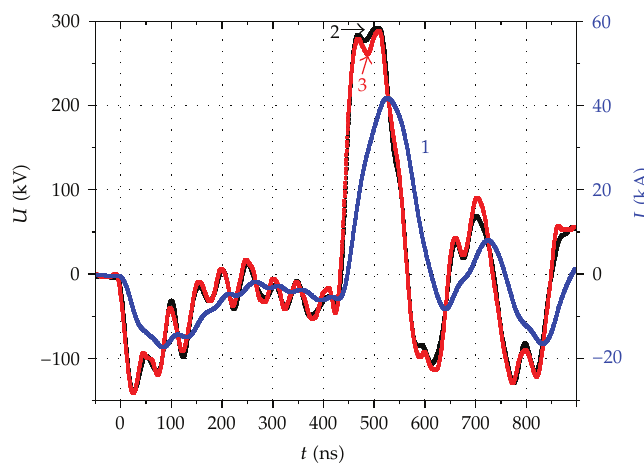
Figure 9: Waveforms of (cid:2) 1 (cid:3) current, (cid:2) 2 (cid:3) experimental, and (cid:2) 3 (cid:3) calculated